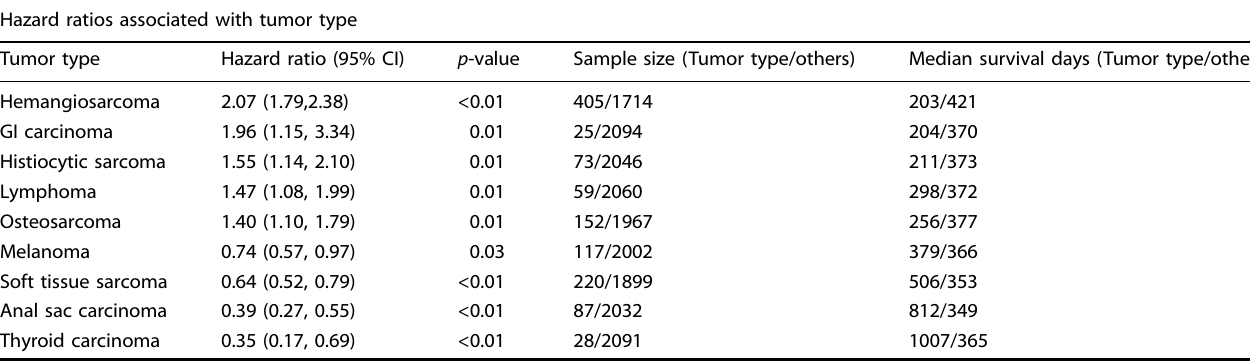
Table 1. Statistically signi fi cant hazard ratios of tumor type on survival from diagnosis. Hazard ratios associated with tumor